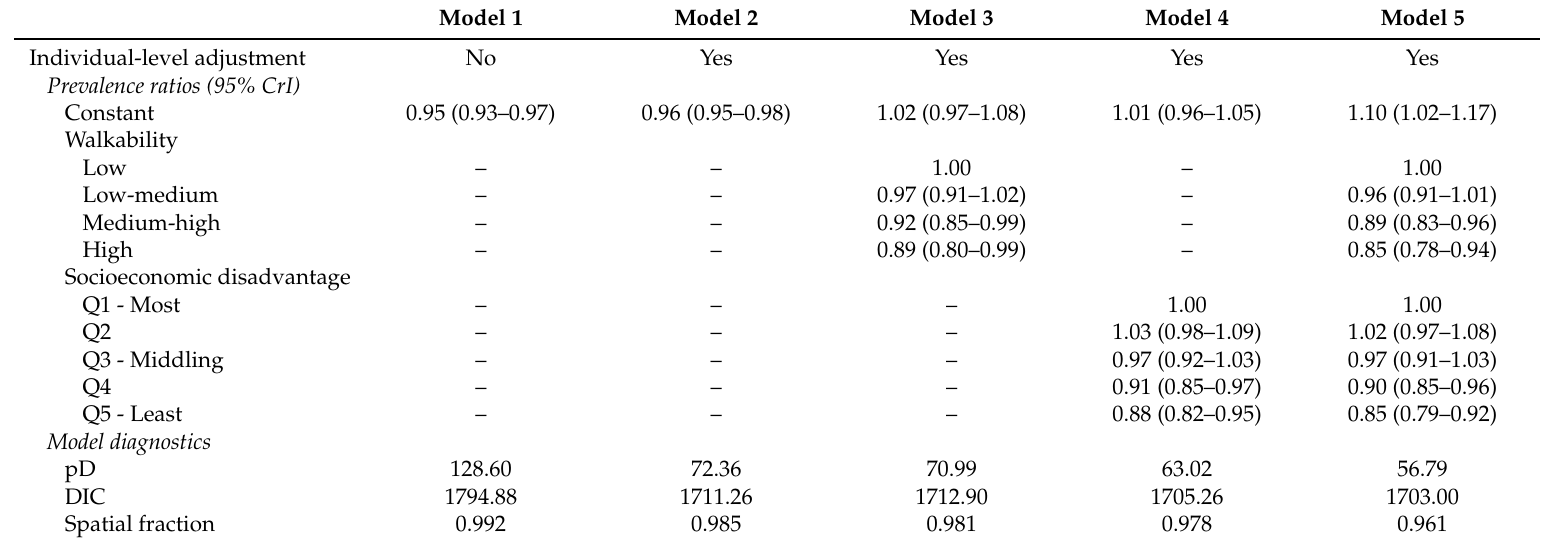
Table 4. Spatial regression summaries for postal area analyses of associations between obesity, walkability and relative socioeconomic